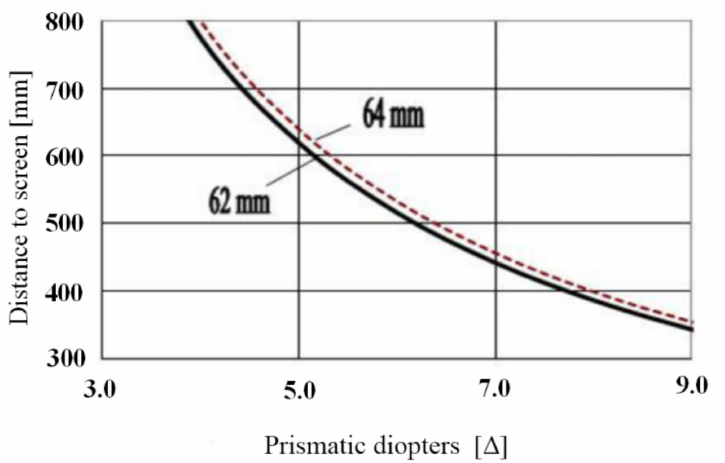
Figure 2. Objective prismatic diopter for anti-fatigue glasses from the consideration of geometri- cal